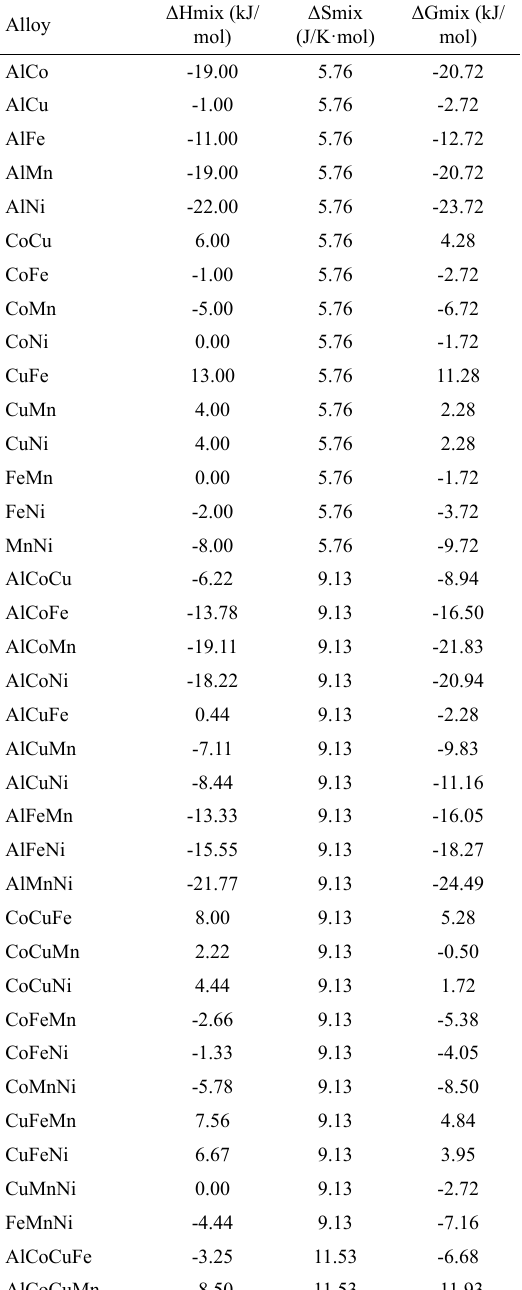
Table 3. Mixing entropy, mixing enthalpy, and Gibbs free energy of the